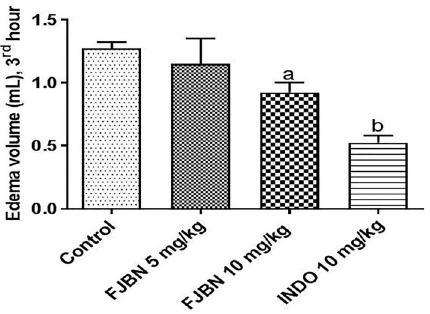
Figure 2. The triterpene-rich fraction from Himatanthus drasticus (FJNB) inhibited the carrageenan-induced paw edema in rats at the 3rd h that corresponds to the maximum effect. Indomethacin (INDO) was used as reference. Data are reported as means ± SE. a P=0.0402 vs Control; b P o 0.0001 vs Control (one-way ANOVA and Tukey ’ s test for multiple